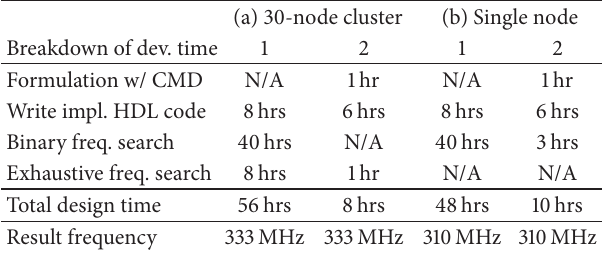
Table 5: Example of productivity gains from using CMD for 8-tap FIR filter. (a) 30-node cluster (b) Single node Breakdown of dev. time